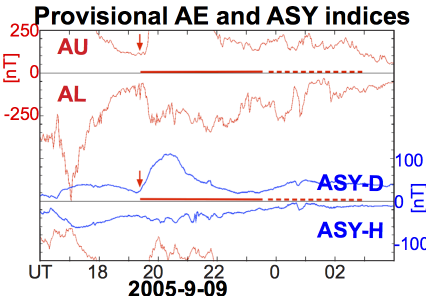
Figure 8. Same format as Fig. 6 for 9 September 2005. A coronal mass ejection (CME) arrived at the Earth at around 13:30UT, and the IMF turned southward at the Earth at around